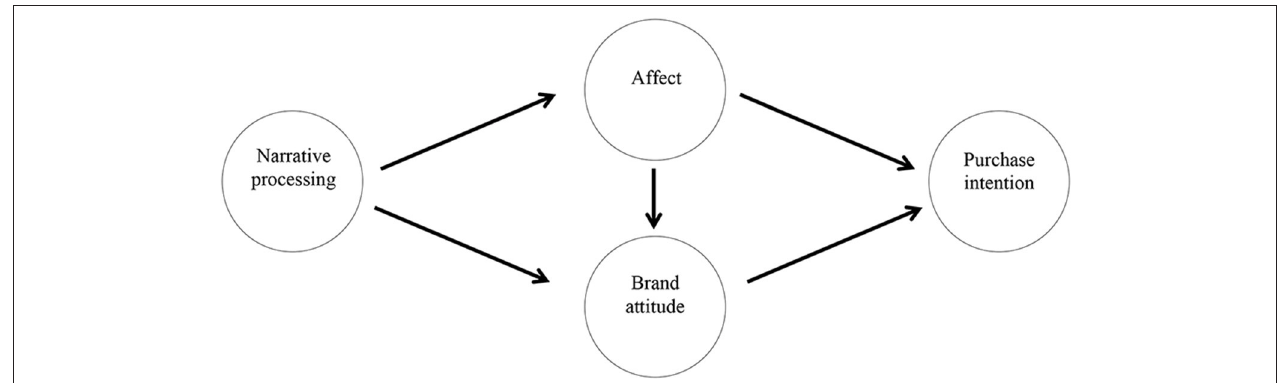
FIGURE 2 | Conceptual model of effectiveness of storytelling in agricultural marketing